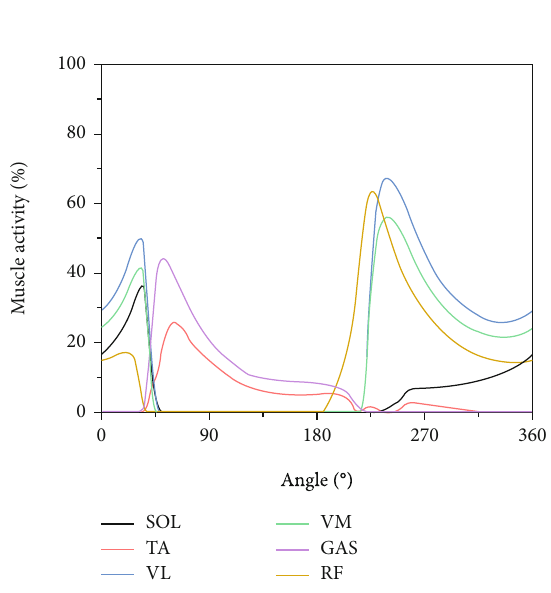
Figure 3: The activity of each muscle when the crank length was